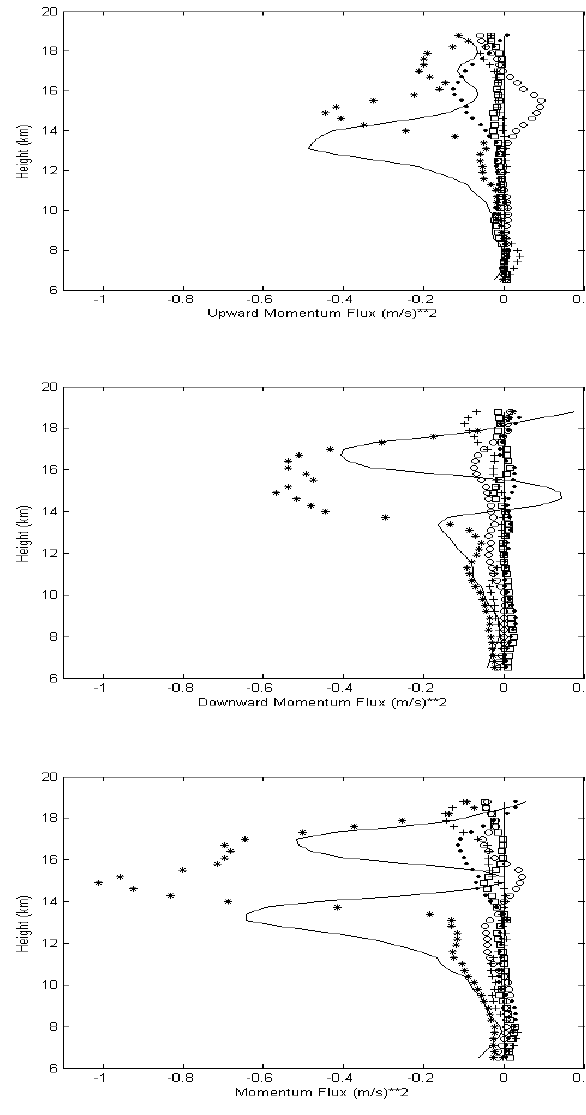
Fig. 5. Same as Fig. 4 except for the 30min–2h period band. Fig.5 Same as Fig.4 except for the 30 min- 2 h period band. Fig. 6. Same as Fig. 4 except for the 2–7h period band. Fig.6 Same as Fig.4 except for the 2- 7 h period band. about 0.028 m/s. Similarly, the peak of the respective down- riod band. The corresponding upward-flux, downward flux ward flux (middle panel of Fig. 5) moved down from the alti- and total flux were represented by “open circle”, “star” and tude of 16.4 km (“line”) to 15.35 km (“star”) with a speed of “line”, respectively. The upward flux (“open circle”) of zonal downward movement about 0.012 m/s. It is also evident from momentum below 17 km for each period band Fig. 6 that the peak of the upward flux of 2–7 h period band moved from 13.25 km (“line” of top panel) to 14.9 km (“star” of top panel) with an upward speed of about 0.019 m/s, and the peak of the downward flux moved from 16.85 km (“line” of middle panel) to 14.9 km (“star” of middle panel) with a downward speed of about 0.023 m/s.